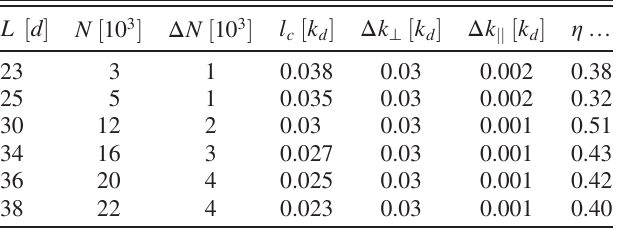
TABLE I. Parameters used to compute the data in Fig. 3. In order to measure the correlation length with a good precision, we use Δ k ⊥ ≈ l , resulting in η ¼ g ð 2 Þ ð δ k ¼ 0 Þ − 1 < 1 . c L ½ d (cid:2) N ½ 10 3 (cid:2) Δ N ½ 10 3